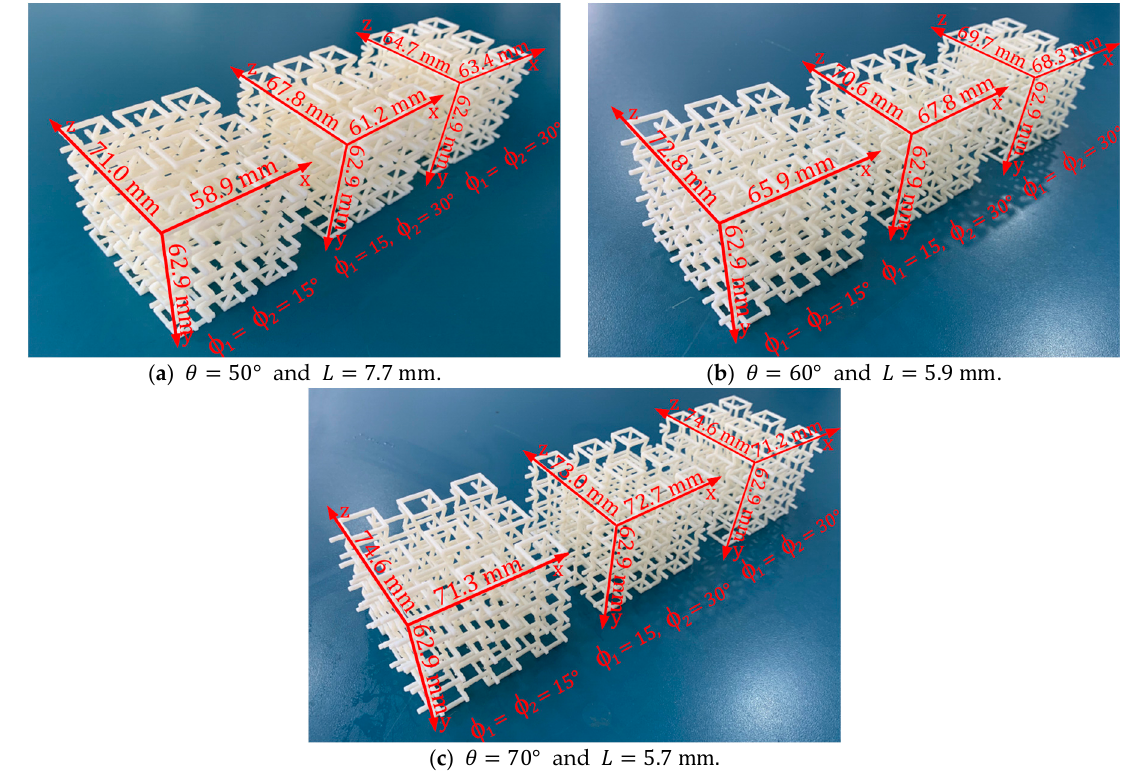
Figure 5. Macrostructures made up of 36-unit cells ( 3 × 3 × 4 ) manufactured through fused filament fabrication. H = 13.6 mm and t = 1.70 mm are considered for all cases.